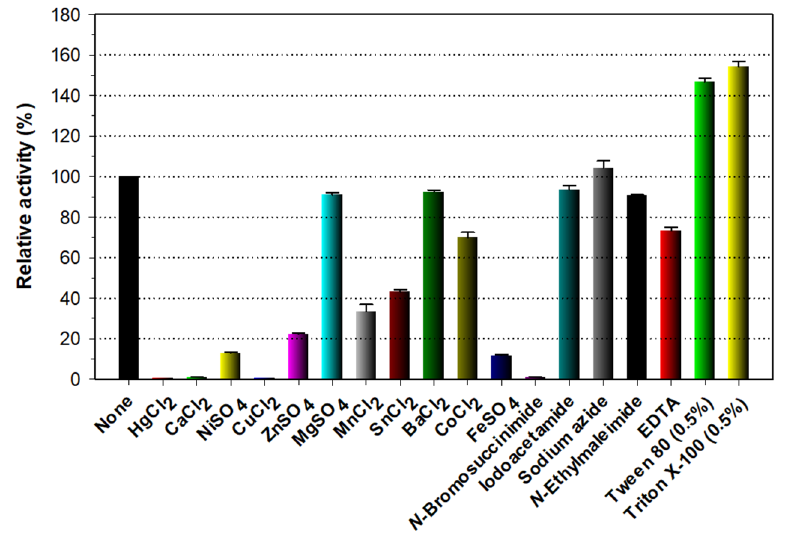
Figure 5. Effects of metal ions (1 mM) and chemical reagents (5 mM) on the endo- β -1,4-xylanase activity of rXylR. The values are mean ± SD of triplicate tests.